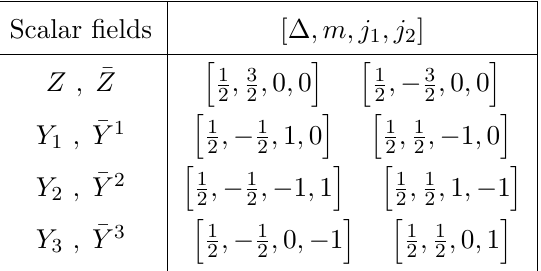
Table 2 . Quantum number assignments to scalar matter fields of the ABJ(M) theory defined in eq. (3.1).